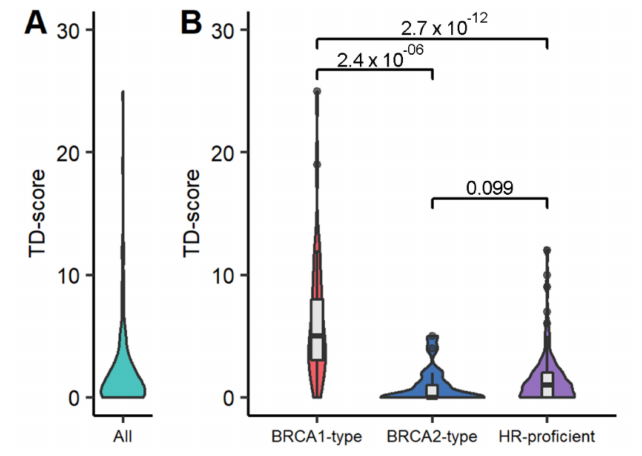
Figure 2. Distribution of TD-score in all samples ( A ) and by CHORD-call ( B ). p -values are from Mann–Whitney U-test. Sample sizes are n = 34, n = 17 and n = 204 for BRCA1- and BRCA2-type HRD and HRP,